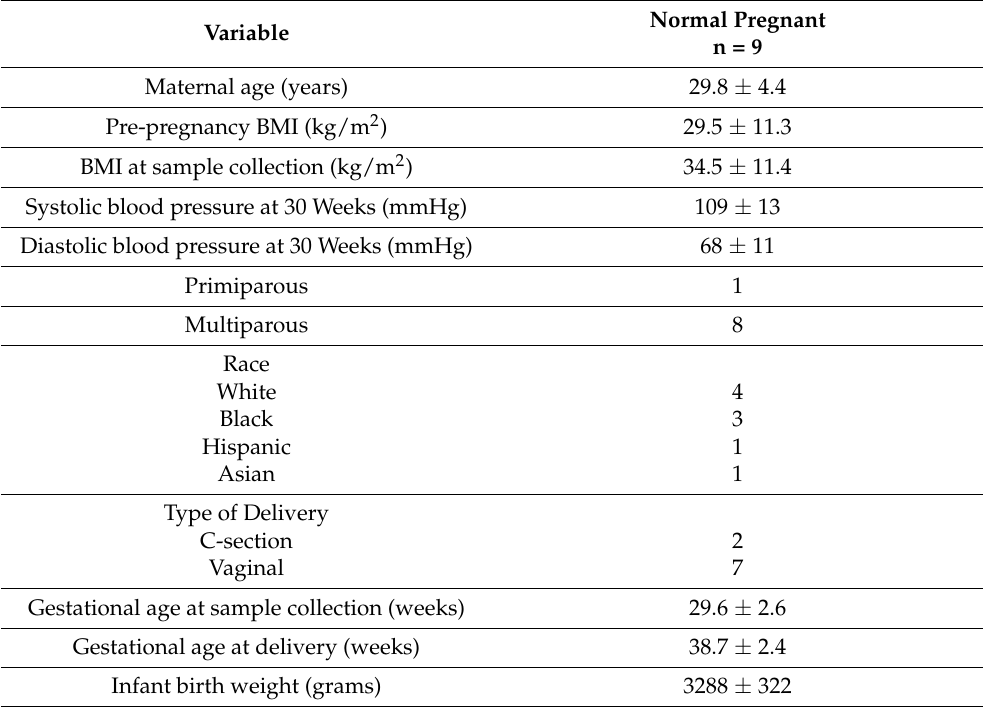
Table 3. Clinical Characteristics of